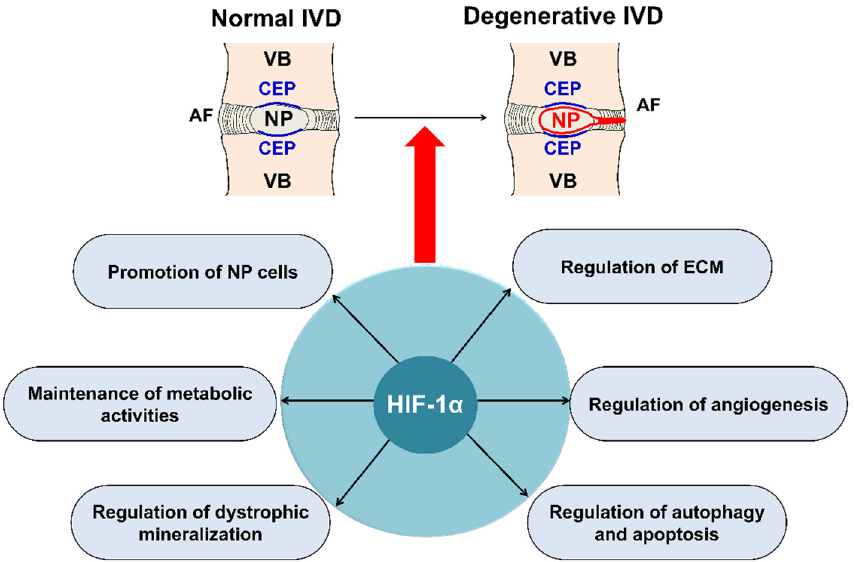
Figure 3. Main roles of HIF-1 α in IVD degeneration. HIF-1 α , involved in IVD degeneration, promotes ECM in NP, maintains the metabolic activities of NP, regulates dystrophic mineralization of NP, and regulates angiogenesis, autophagy, and apoptosis during IVD degeneration. HIF; hypoxia inducible factor, IVD; intervertebral disc, ECM; extracellular matrix, NP; nucleus pulposus, AF; annulus fibrosus, CEP; cartilage endplate, VB; vertebral body.